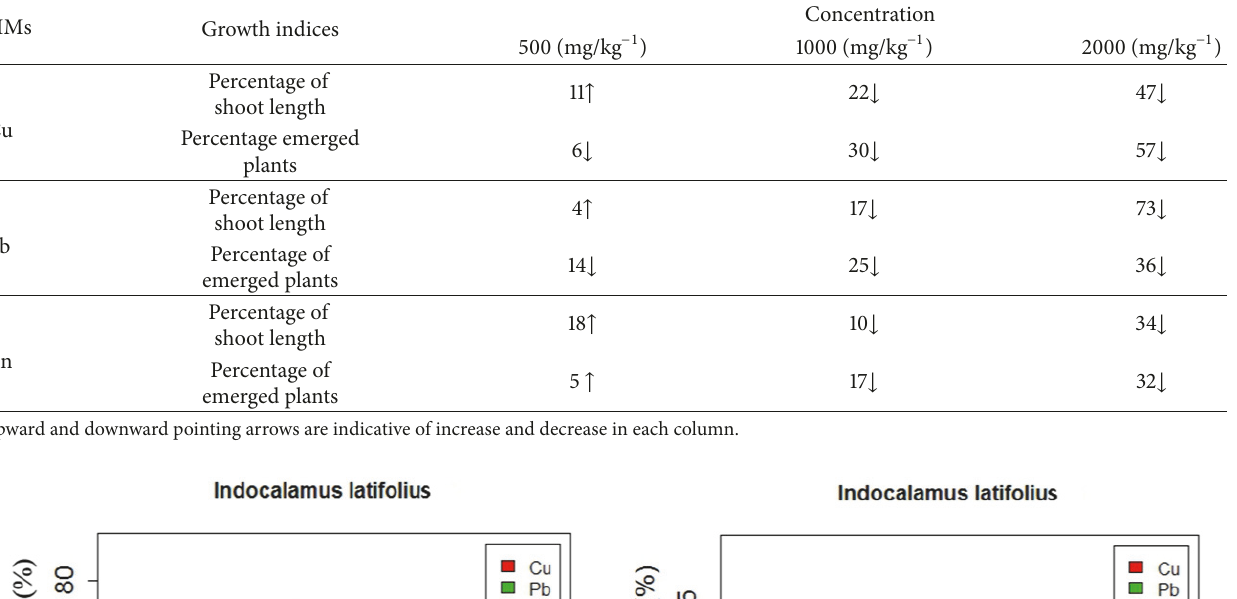
Table 3: Effects of different concentrations of HMs on growth indices Indocalamus latifolius.